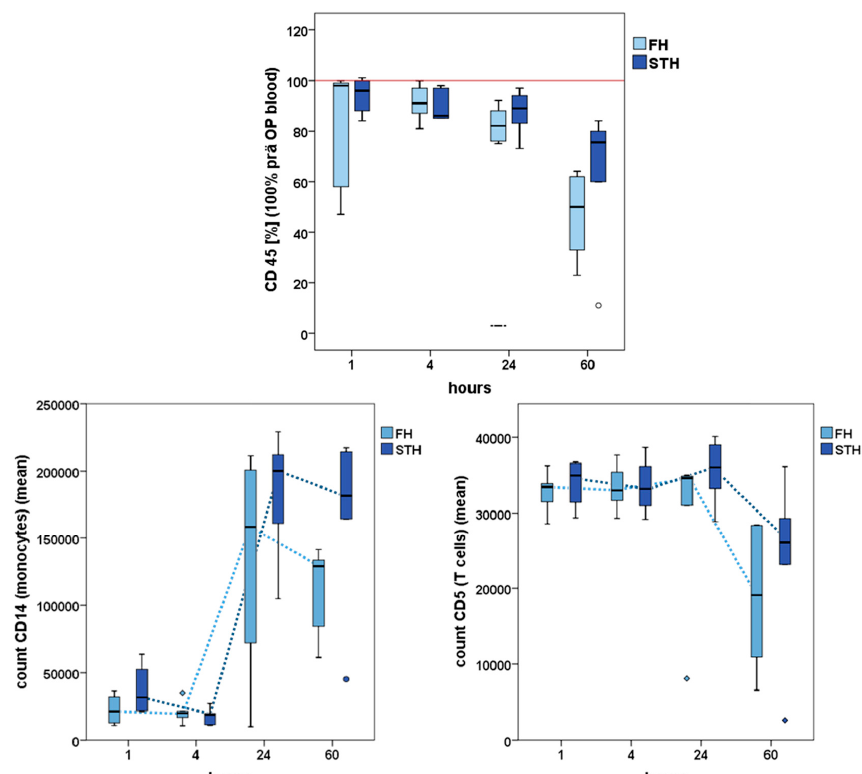
Figure 4. Immune cell percentages in a bone (FH) and a muscle haematoma (STH) over a time course of 60 h: CD45 (leucocytes) percentages are normalized to pre-injury peripheral blood (100%). While being similar to peripheral blood 1 h after injury, leucocytes start to decrease and are clearly lower in bone compared to muscle haematoma at 60 h. Cell counts (normalized to 50,000 leucocytes) show a monocyte increase between 4 and 24 h after injury in bone but a much steeper increase in muscle haematoma. T cell ratios decrease during haematoma maturation, with less T cells in bone compared to muscle haematoma at 60 h, indicating a shift from pro- to anti-inflammation. (Data were acquired with FACS analyses from haematoma generated in sheep: bone haematoma = tibia diaphyseal defect; muscle haematoma = defect in the M. gracilis; n = 6 each). Statistic was performed using Mann Whitney U for unpaired samples and Wilcoxon for paired samples, for a descriptive comparison: CD45: FH—1 to 4 h p = 0.071, 24 to 60 h p = 0.065, STH—24 to 60 h p = 0.026; CD14: FH—4 to 24 h p = 0.082, STH—1 to 4 h p = 0.063, 4 to 24 h p = 0.004 60 h; CD5:FH—24 to 60 h 0.041, STH—24 to 60 h p =